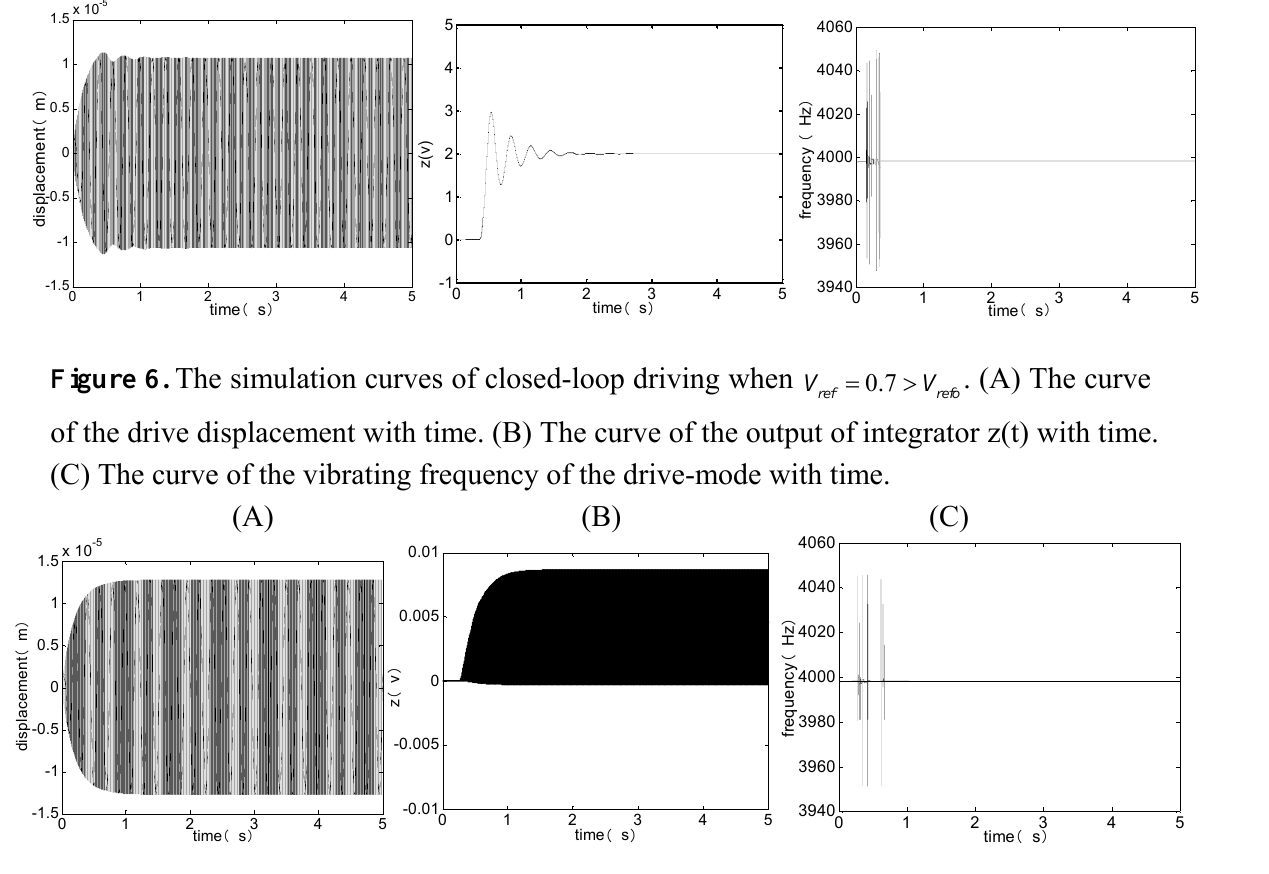
Figure 5. The simulation curves of closed-loop driving when 0.5 of the drive displacement with time. (B) The curve of the output of integrator z(t) with time. (C) The curve of the vibrating frequency of the drive-mode with time.